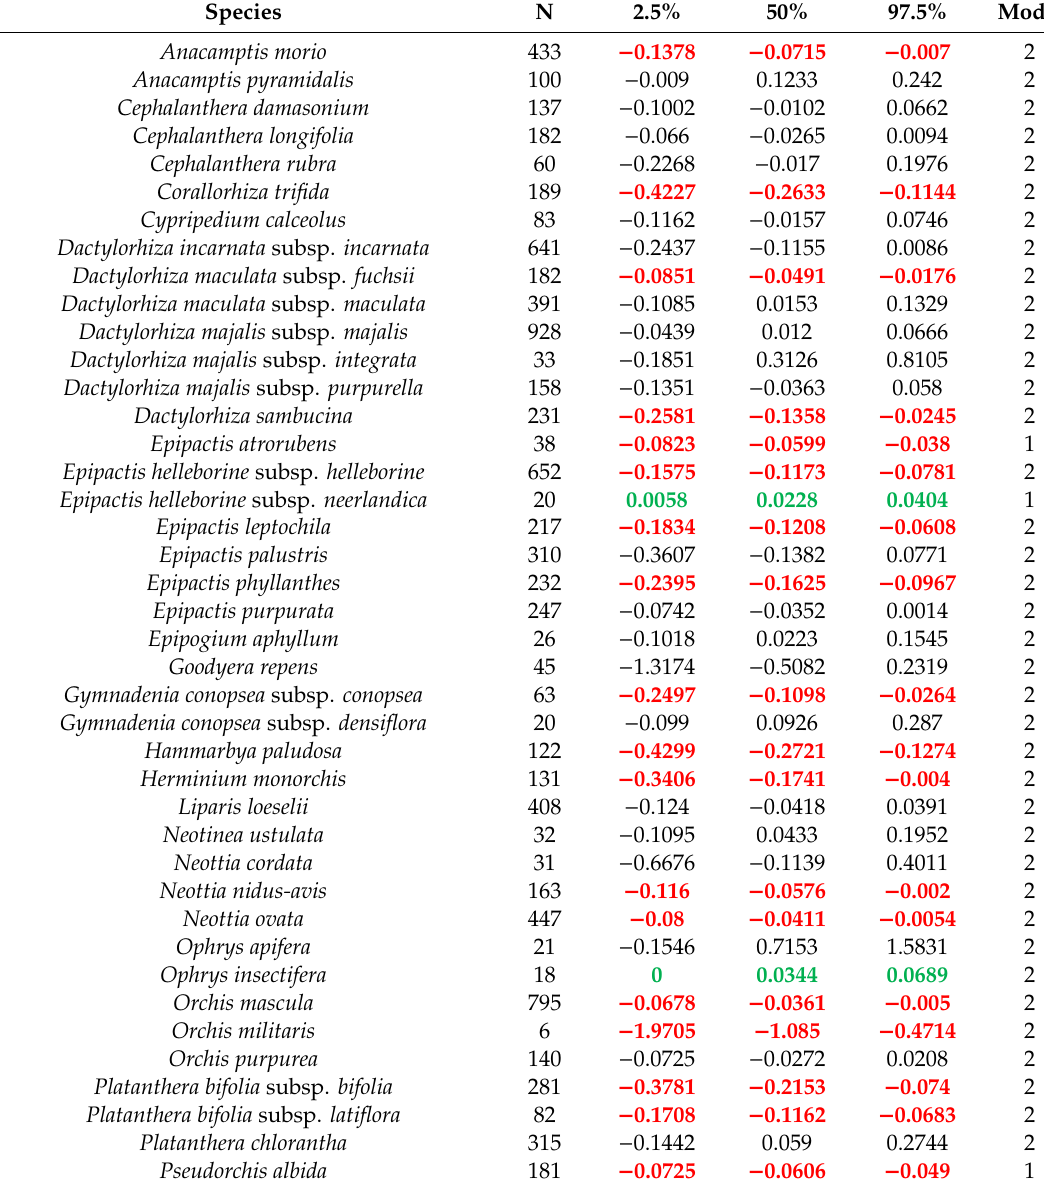
Table 3. The number of observations, N; percentiles of the marginal distribution of the average change over time (bold green numbers denote a significant increase and bold red numbers denote a significant decrease), β ; and the model (Equation (1) or Equation (2)) that was best supported by the